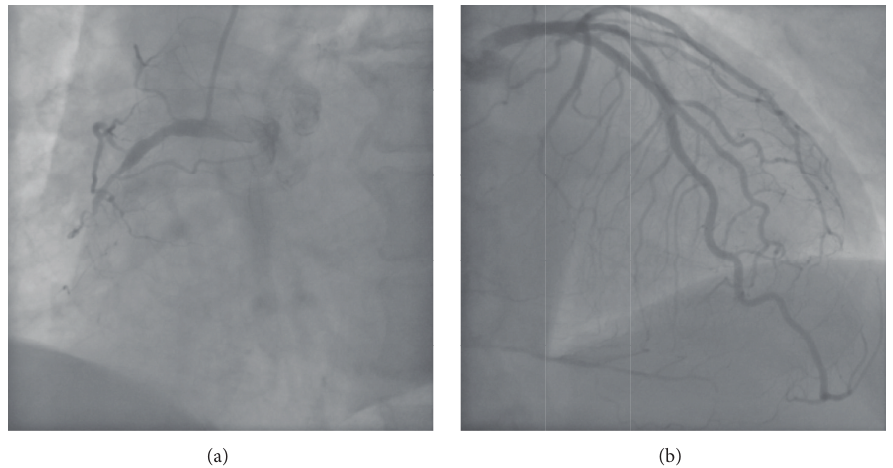
Figure 1: Diagnostic coronary angiography. (a) Chronic total occlusion of right coronary artery (RCA). (b) Retrograde filling of the distal RCA from the left anterior descending artery (LAD).